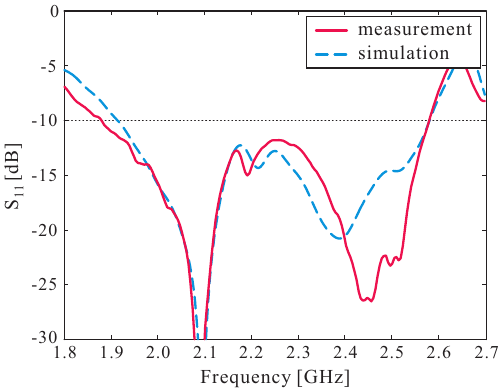
Figure 8. Measured and simulated reflection